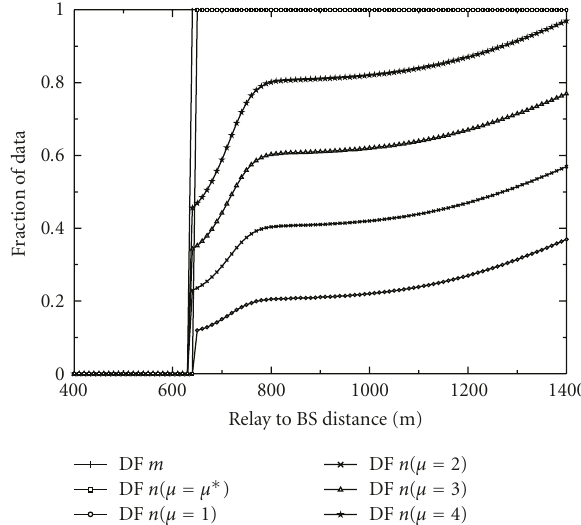
Figure 11: Fraction of cooperation data versus di ff erent locations of the relay under DF